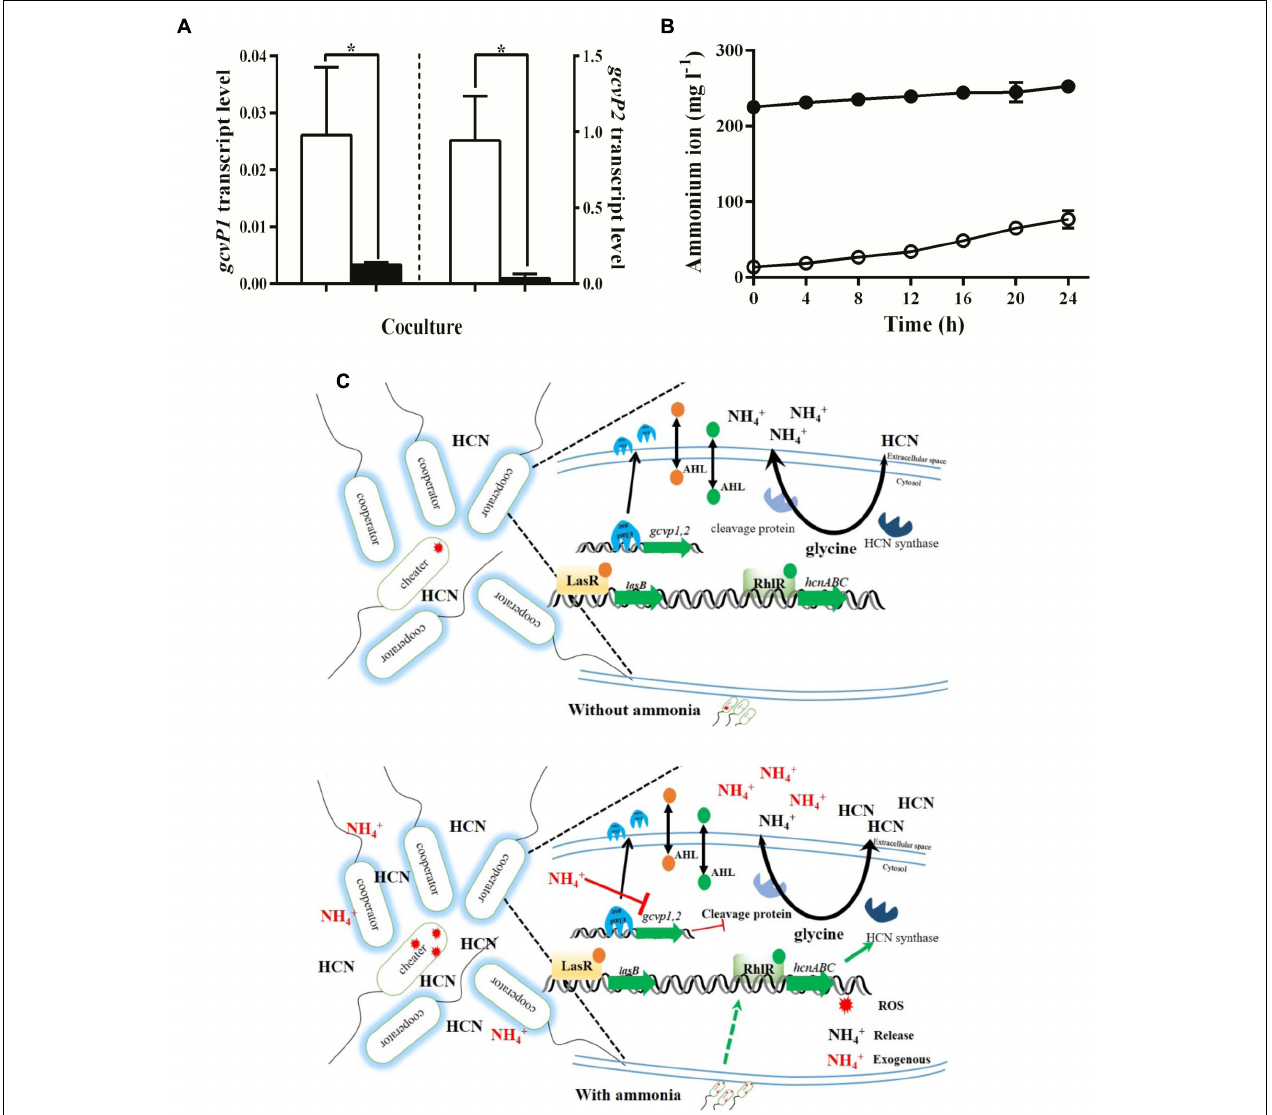
FIGURE 4 | Exogenous ammonia inhibits the transformation from glycine to 5,10-methylene-THF. (A) Expression of gcvP1 and gcvP2 by the w.t. in a co-culture with 10% LasR mutants. Hollow bars indicate PM-casein without ammonium sulfate and black bars indicate PM-casein with ammonium sulfate. proC was used as a housekeeping gene. (B) PAO1 generates ammonia faster in the absence of ammonium sulfate (hollow circles) than in its presence (black circles). (C) Model of the flux between exogenous ammonia and cyanide production in P. aeruginosa . In panel C , red stars indicate ROS. The red NH + 4 indicates exogenous ammonia in media, and black text indicates released ammonia by metabolism. Experiments were performed in triplicate. ∗ indicates p < 0.05 by paired Student’s t -test (panel A ) or one-way ANOVA (panel B